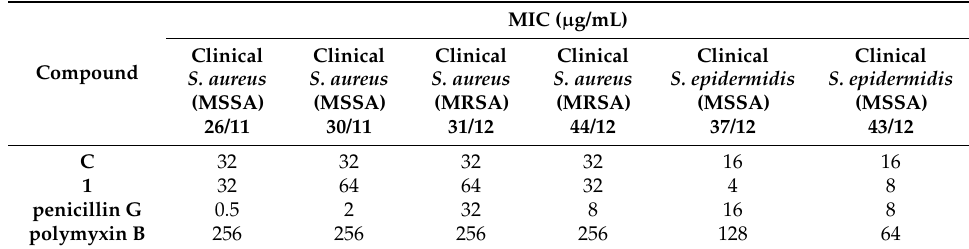
Table 4. In vitro antibacterial activity of complexes 1 and C compounds against clinical isolates (MIC µ g/mL) a